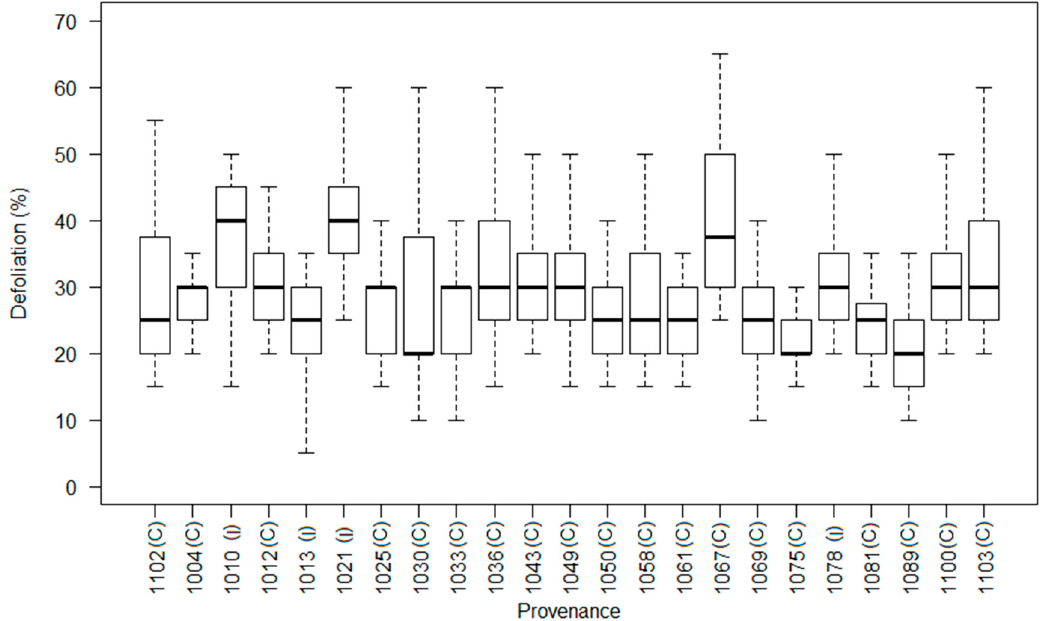
Figure 2. Box plot for defoliation rates of individual provenances. Whiskers represent 1.5 times the inter-quartile range. The letter above the provenance means coastal (C) or interior